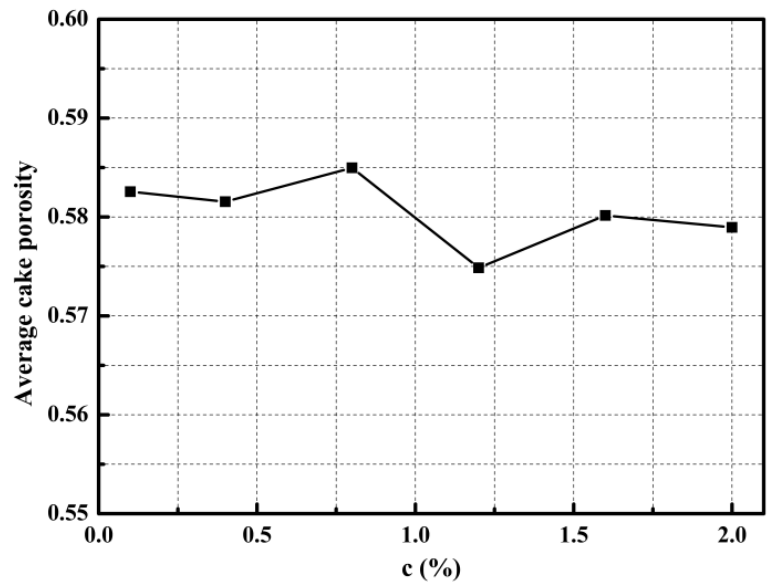
Figure 10. Effect of particle concentration on average porosity of filter cake.